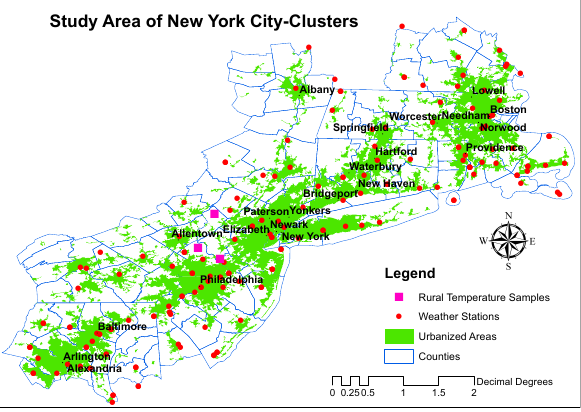
Figure 5: Urbanized areas in the northeast region of the USA. weather stations along the coastline of New York representing a large urban area (Figure 5). Data were collected hourly from June 7, 2014 at 9.00 am to June 10, 2014 at 9.00 am. To have represen- tative rural temperature for extracting zones of UHIs, three rural temperatures were collected and averaged each hour as the refer- enced rural temperature. Then, zones of UHIs were extracted au- tomatically such that temperatures within which are higher than the referenced rural temperature. 102 sample points are located in the urbanized area, which ensures that a sufficient number of UHIs covering multiple urban areas can be generated. Tempera- tures over the whole area of study were interpolated by Universal Kriging, providing a temperature image at each time instant.